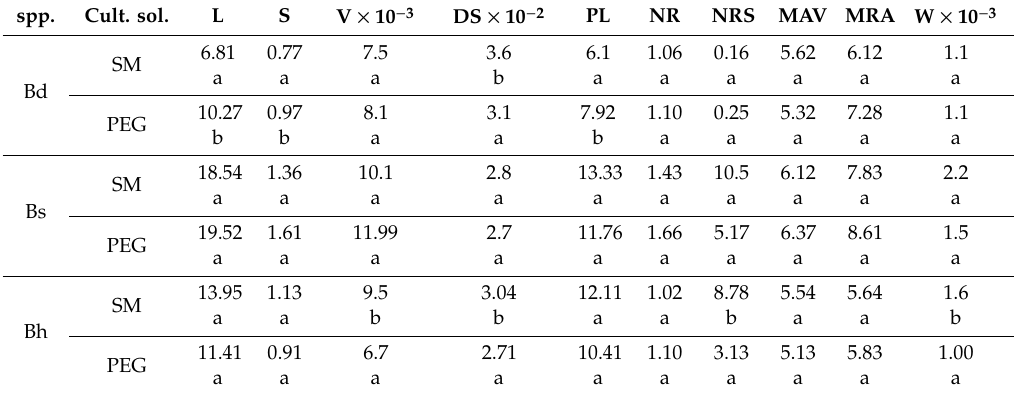
Table 2. Mean of RSA variables and W in SM and PEG solutions for each Brachypodium species. Different letters indicate statistical significance at p < 0.05 level of probability.